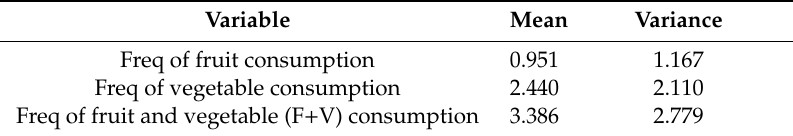
Table 1. Mean and variance of the fruit and vegetable consumption